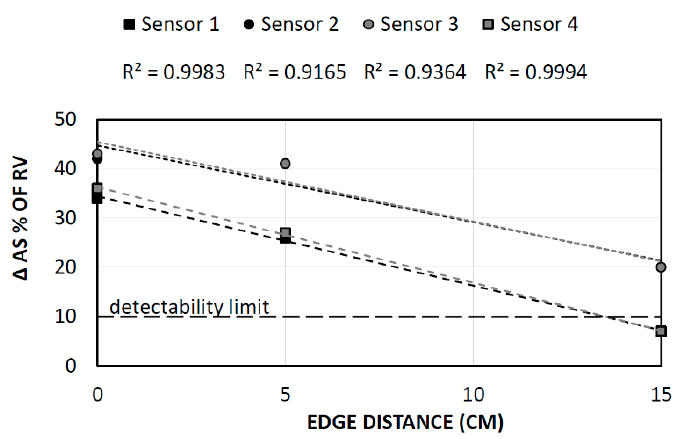
Figure 16. Frequency spectra, edge 15 cm from impactor; expected frequency marked with dashed line.